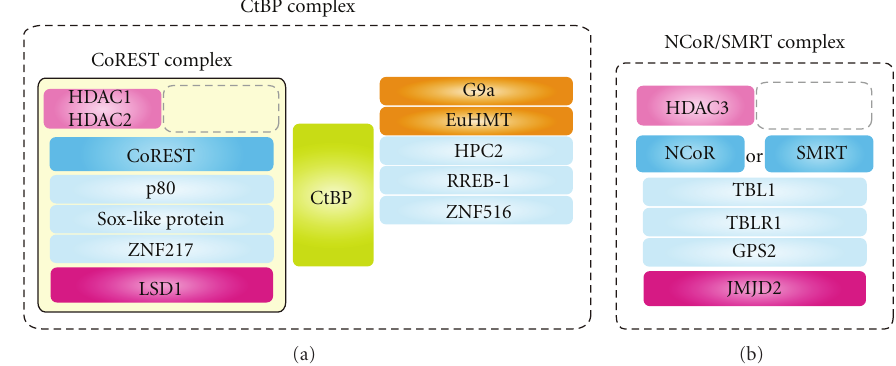
Figure 3: The CoREST and NCoR/SMRT complexes. Schematic representation of the CoREST (a) and the NCoR/SMRT (b) complexes. The CoREST complex is included in the CtBP-containing complexes. The empty dotted boxes indicate that both CoREST and NCoR/SMRT complexes lack RbAp46/RbAp48 subunits, which are widely observed in HDAC-containing complexes.